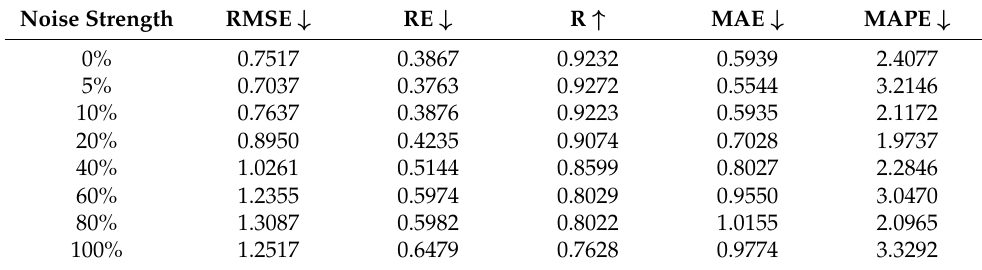
Table 4. Quantitative analysis on different strengths of load